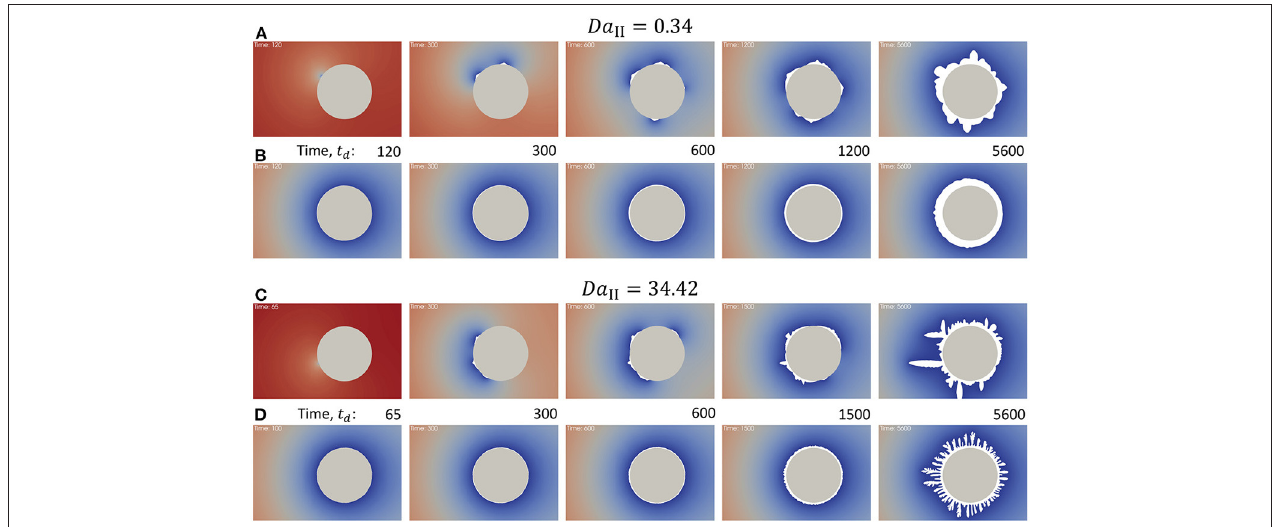
FIGURE 4 | Precipitation on a particle in flow, Pe = 0.71. Time when the snapshots were taken is shown in time units, t d . (A) Da II = 0.34 and nucleation is “on,” initial surface is inert. (B) Da II = 0.34 and nucleation is “off,” initial surface is reactive. (C) Da II = 34.42 and nucleation is “on.” (D) Da II = 34.42 and nucleation is “off.”